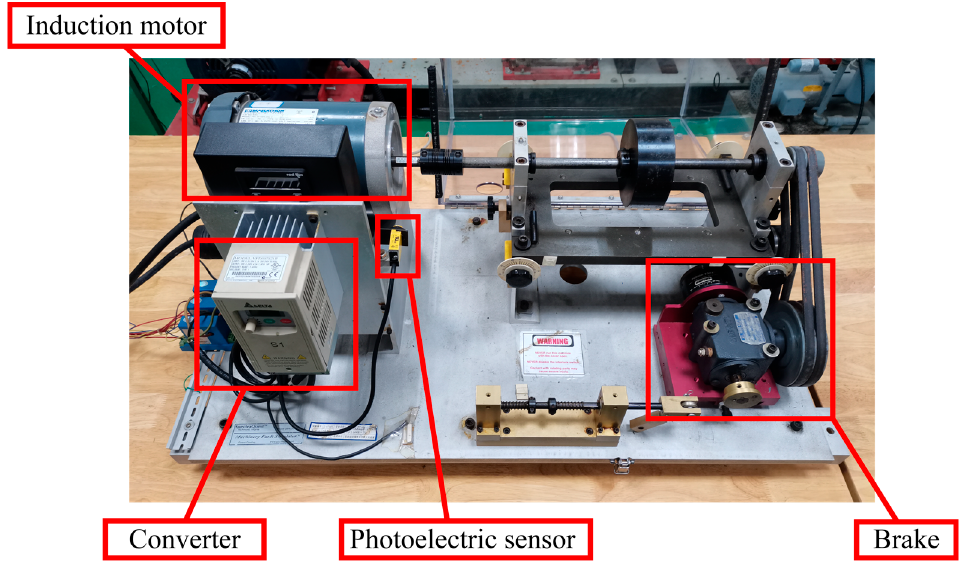
Figure 19. The machinery fault simulator.